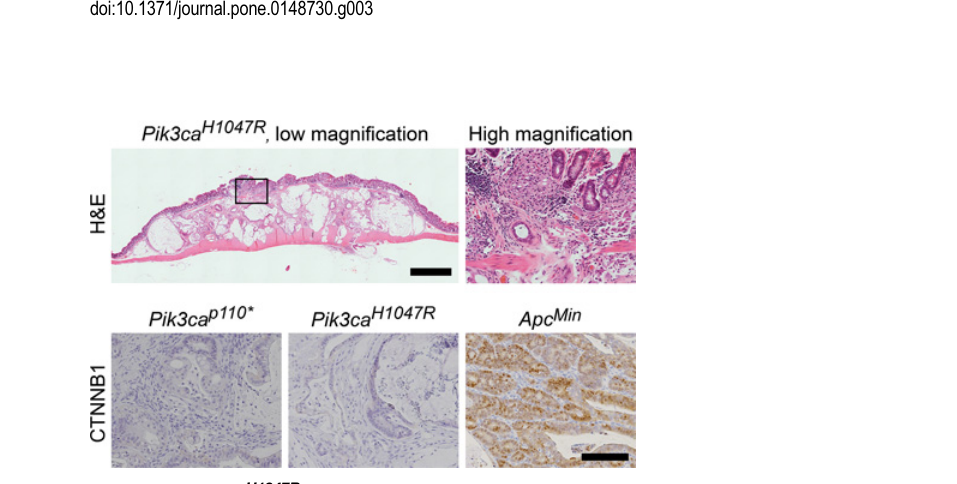
Fig 4. Fc + Pik3ca H1047R colon cancers develop through a non-canonical pathway. Histological examination demonstrates that these cancers are flat without a polypoid component. Low grade dysplasia (tubular adenoma) has not been identified in these or the Fc + Pik3c a p110 * mice. At higher magnification, malignant glands above the muscularis mucosa can be identified which appear to be originating from the crypt bases without identification of surface low grade dysplasia. CTNNB1 staining demonstrates that nuclear CTNNB1 is absent in both of the Pik3ca mutant models, but is present in the Apc Min controls. Scale bar for low magnification image = 1mm. High magnification H&E image is a 6x magnification of the area indicated in the image to the left. Scale bar for CTNNB1 images = 100 μ m.